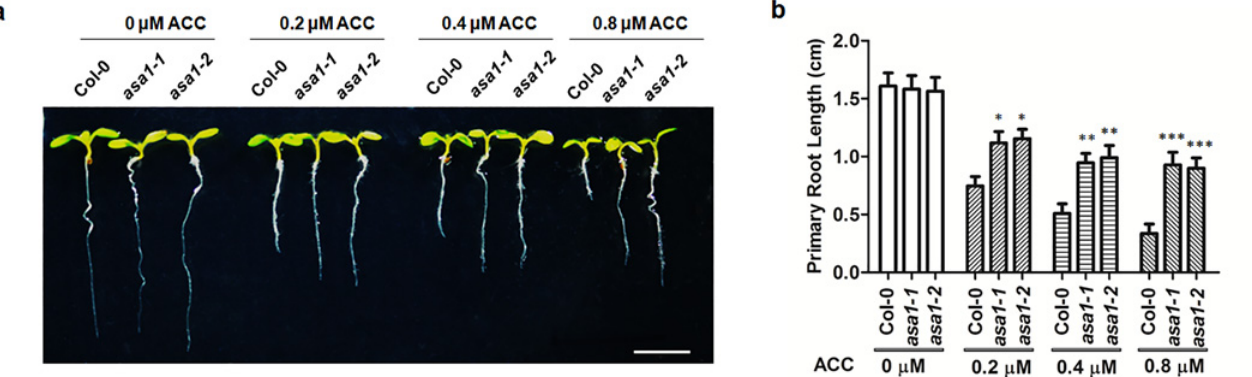
Fig 6. Root elongation of asa1 mutants in response to ACC treatment. ( a ) Root elongation of Col-0 and asa1 without and with ACC treatment. CS16398 ( asa1-1 ) and CS16397 ( asa1-2 ) are two different loss-of- ASA1 mutants. Seeds of Col-0 and asa1 were grown on MS plates without or with ACC for 5 d. Three independent experiments were displayed with similar results. Representative seedlings were photographed. Scale bar, 0.5 cm. ( b ) The primary root length of 5-day-old Col-0 and asa1 mutants grown on medium without or with ACC. Values are mean ± SD of three replicas ( * P < 0.05, ** P < 0.01, *** P < 0.001). Each replica contains 30 plants for each line. Asterisks indicate Student ’ s t-test significant